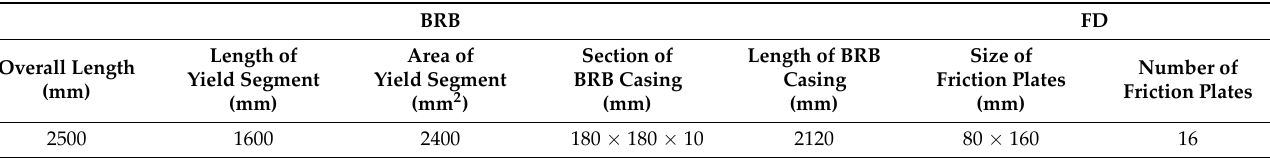
Figure 8. Configuration and sectional drawing of the FBRB specimen. Table 2. Geometric parameters of the FBRB specimen.